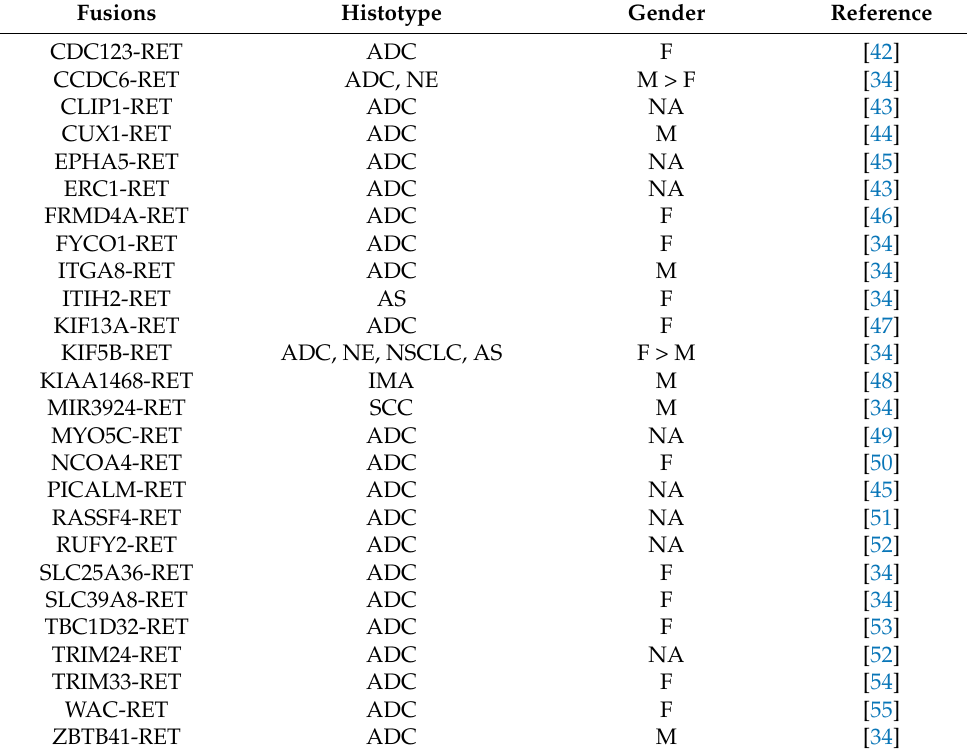
Table 1. Other rearrangements and RET